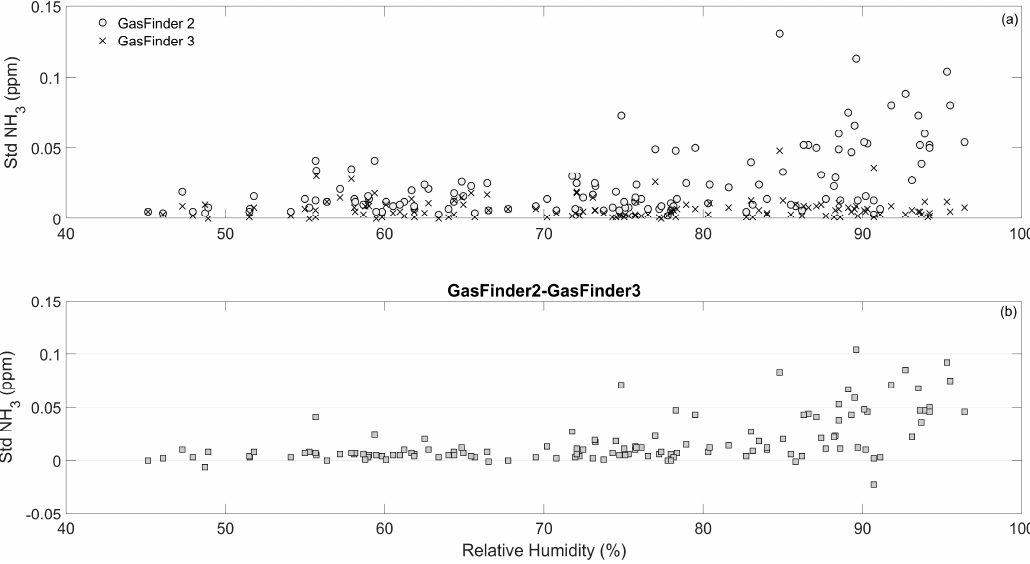
Figure 6. ( a ) Standard deviations on a 30 min period basis of NH 3 concentrations measured by the GF2 and GF3 versus relative humidity measured from the on-site weather station at the field trial before fertilization and after fertilizer application. ( b ) Differences in standard deviations of NH 3 concentrations between GF2 and GF3 versus relative humidity.